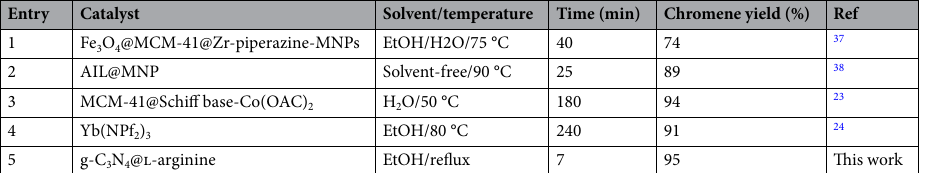
Table 5. Comparison of catalytic activity of g-C 3 N 4 @l-arginine with other reported catalysts for the synthesis of 4H -chromene derivatives. Reaction conditions: benzaldehyde (1 mmol), dimedone (1 mmol), malononitrile